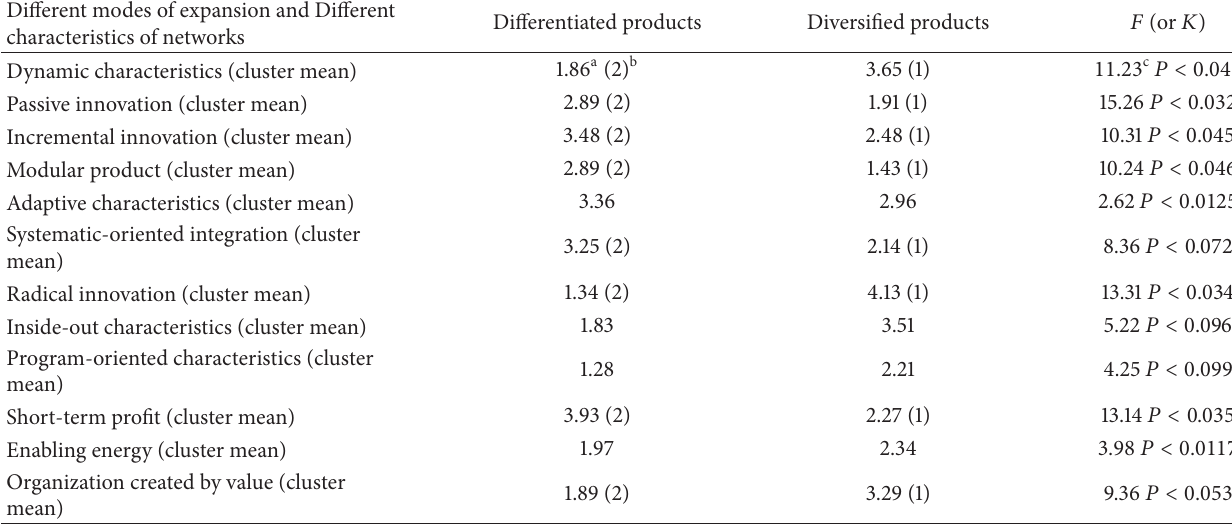
Table 3: Characteristics of networks under different expansion